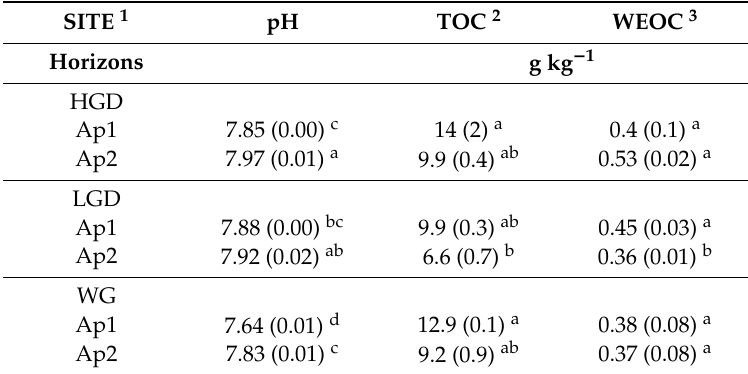
Table 1. Values of pH, and contents of total organic C, and water extractable organic C of the vineyard soils with a high and low geese density, and of the soil of the control vineyard. Numbers in parentheses are the standard errors ( n =